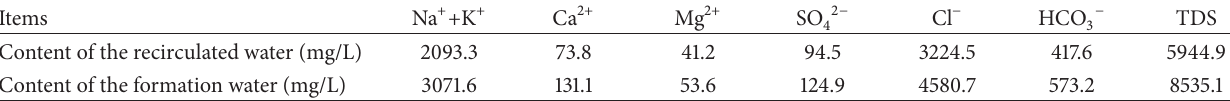
Table 2: TDS and chemical composition of the formation water and the recirculated